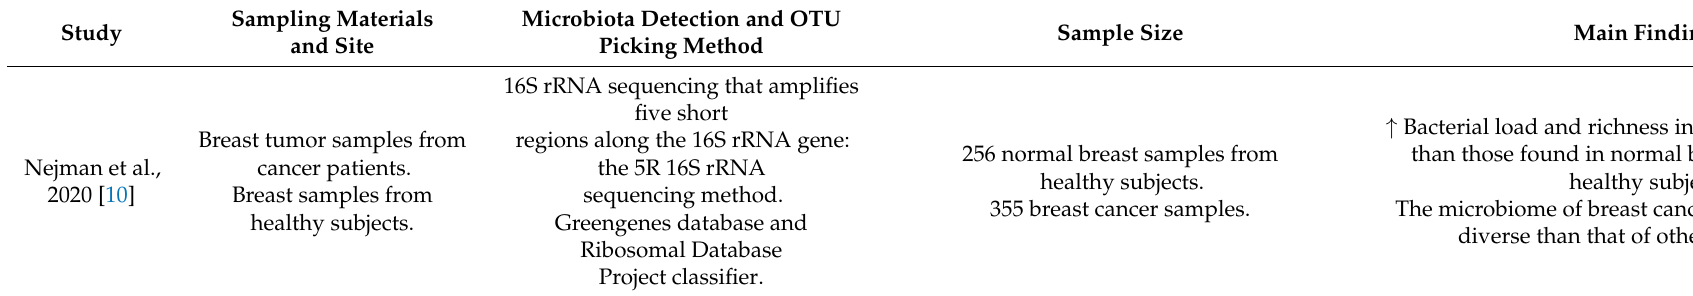
Table 1. Clinical trials dealing with breast cancer and